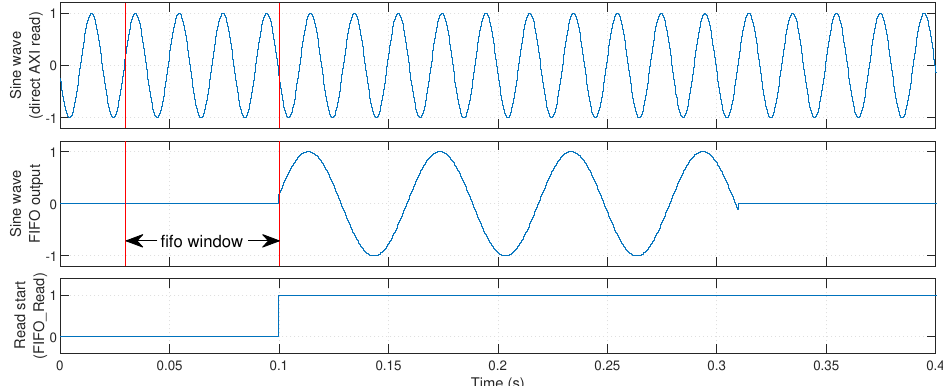
Figure 15. Sine wave full-sampled acquisition using a FIFO window of 1000 samples, starting 999 samples before the trigger instant.